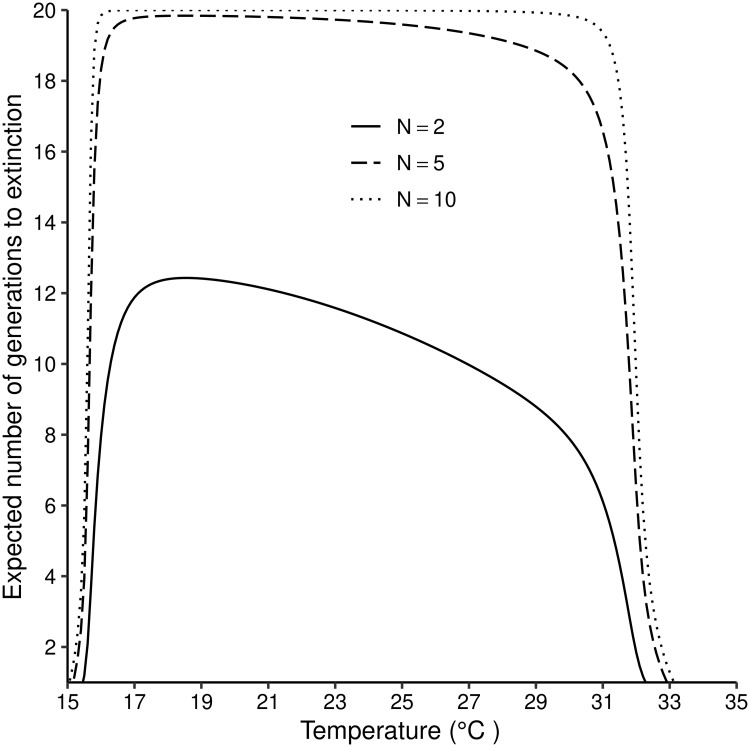
Expected number of generation to extinction of a G. m. morsitans population for different number of females in the initial population at different temperatures (15°C–35°C).Eq (8) is solved iteratively up to n = 20.